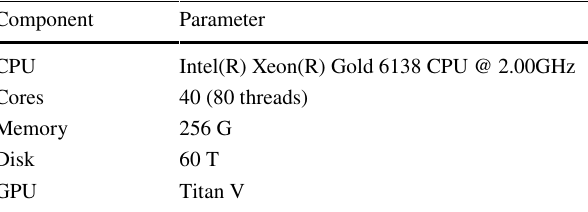
Table 8 Hardware